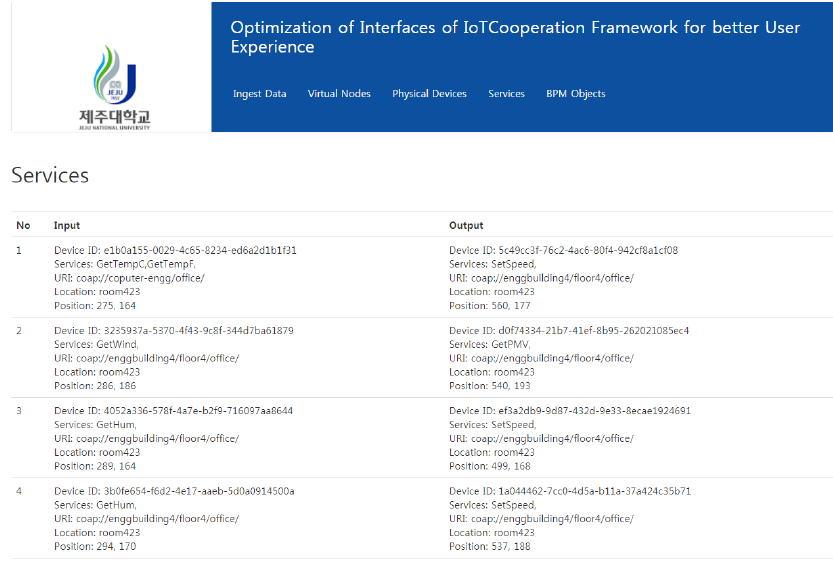
Figure 11. Services representation in the cloud.